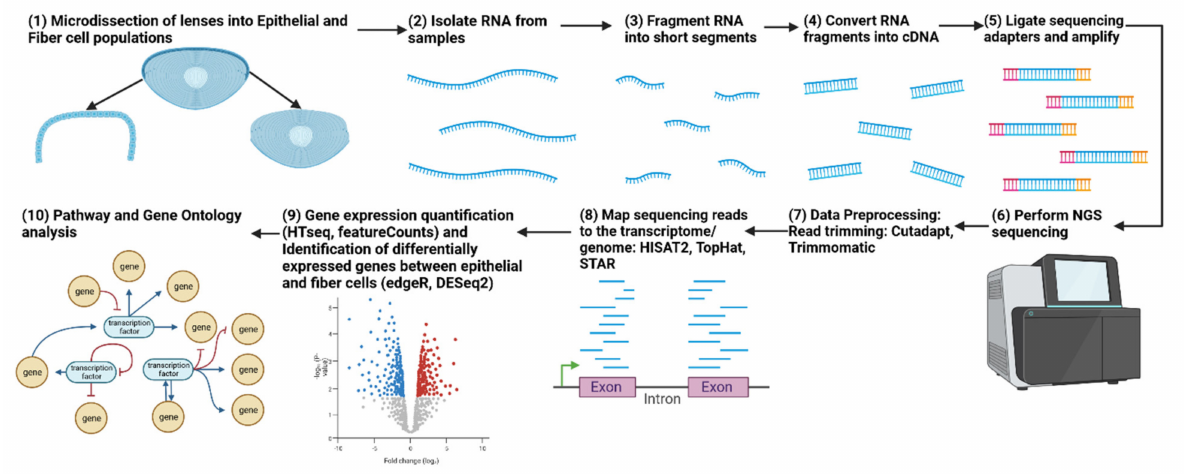
Figure 2. Workflow for an RNA-seq experiment comparing lens epithelial cells and fiber cells. The figure illustrates the sequential steps involved in the RNA-seq experiment, beginning with the isolation of lens epithelial and fiber cells, followed by RNA extraction, library preparation, sequencing, data preprocessing, differential gene expression analysis, and downstream functional enrichment analyses to identify the molecular mechanisms controlling lens differentiation. Adapted from “RNA Sequencing” by BioRender.com (2023) . Retrieved from